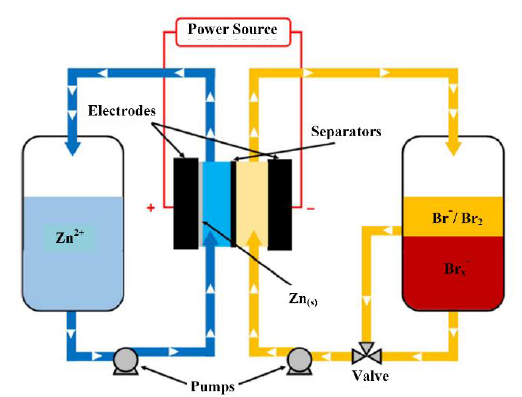
Figure 50. Simplified schematic of the Zinc-Bromine redox flow battery. Zn is used as the solid negative electrode and Br is the electroactive material dissolved in an aqueous solution and used as the positive electrode [158].